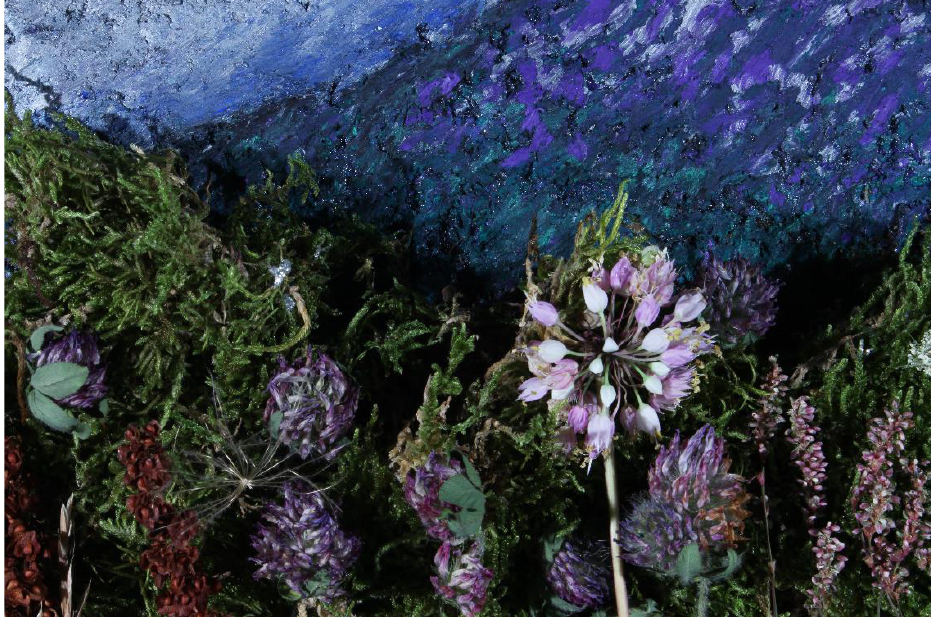
Figure 4. Plants march across the screen and seemingly return our gaze, The Fourfold (2020).